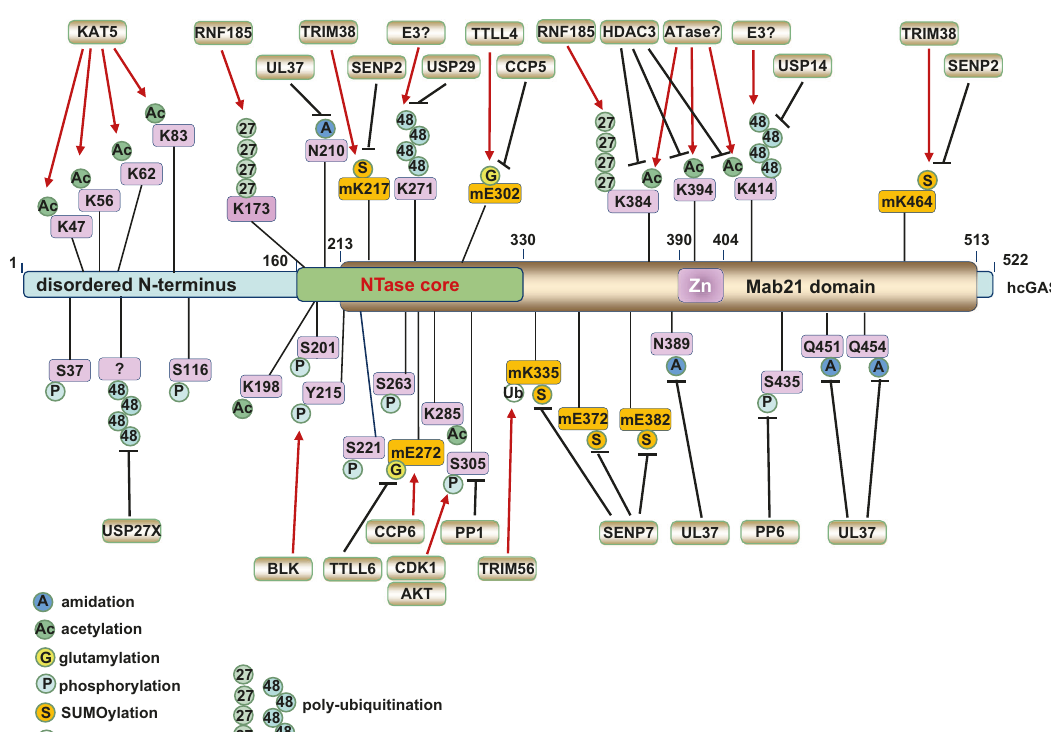
Fig. 3 Regulations of cGAS activation by cGAS post-translational modi fi cations. cGAS is dynamically regulated by various post- translational modi fi cations in responding to DNA insults, such as monoubiquitination, polyubiquitination, SUMOylation, glutamylation, phosphorylation, acetylation, and deamidation in cells. This fi gure illustrates up-to-date reported post-translational modi fi cations occurring on cGAS proteins, including the modi fi ed residues and modifying enzymes. Please note that all human cGAS residues are labeled in pink while all mouse cGAS residues are labeled in orange with “ m ” inserted in front of the